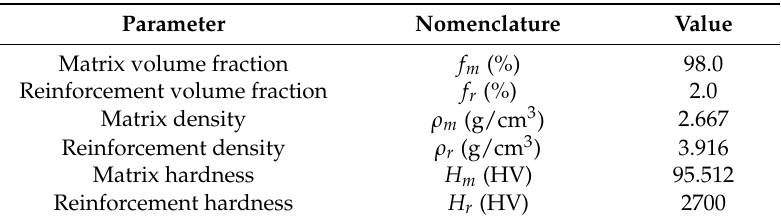
Table 1. Initial as-received (AR) material properties.